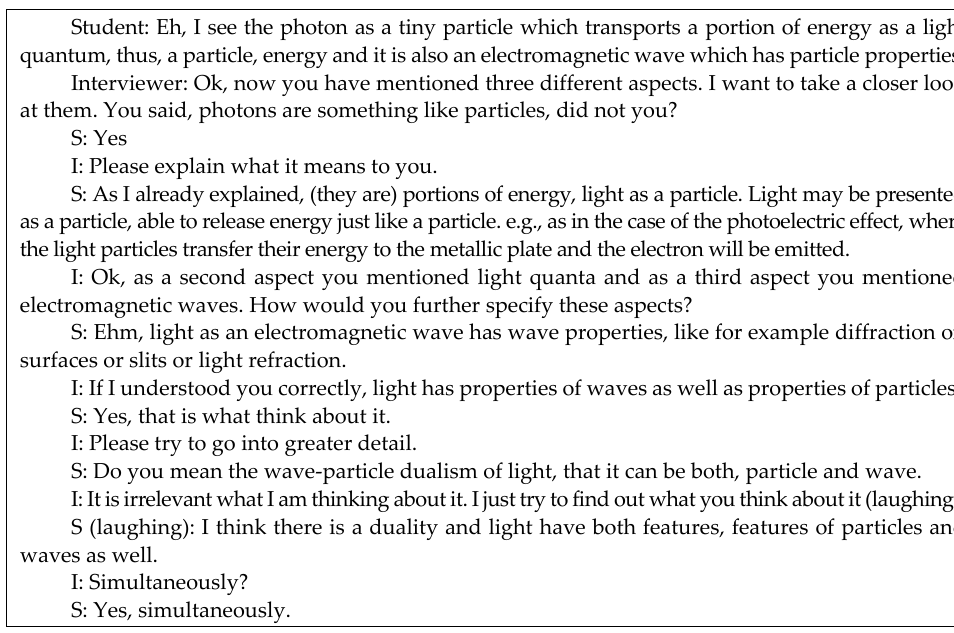
Table 4. Categorial system used to analyse the interview data; the first column refers to the three basic tasks, the second and third columns show main categories and subcategories derived from paraphrasing the individual responses, paraphrases are described in the fourth column, the last column gives an